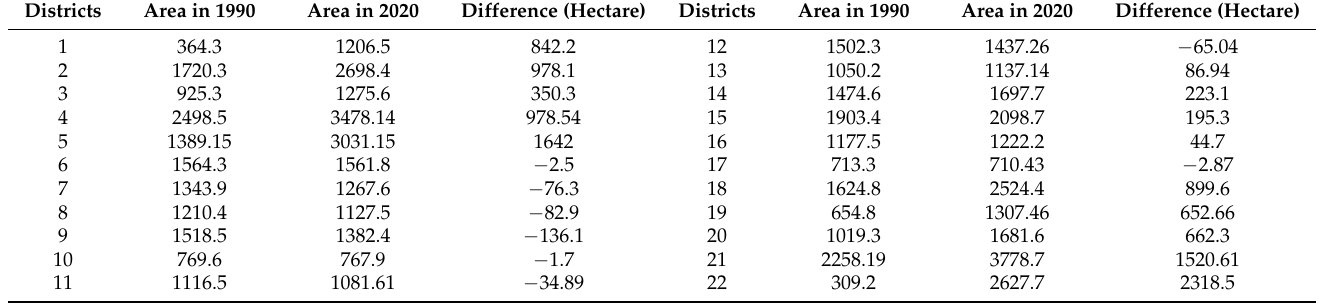
Table 4. The area of constructed lands and its difference in the districts of Tehran metropolis in the period of 1990–2020.